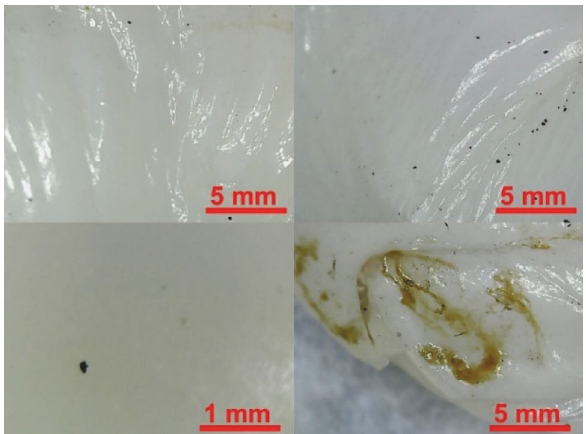
Figure 2. Optical microscopic images of Kombucha Scoby layer in different scales.